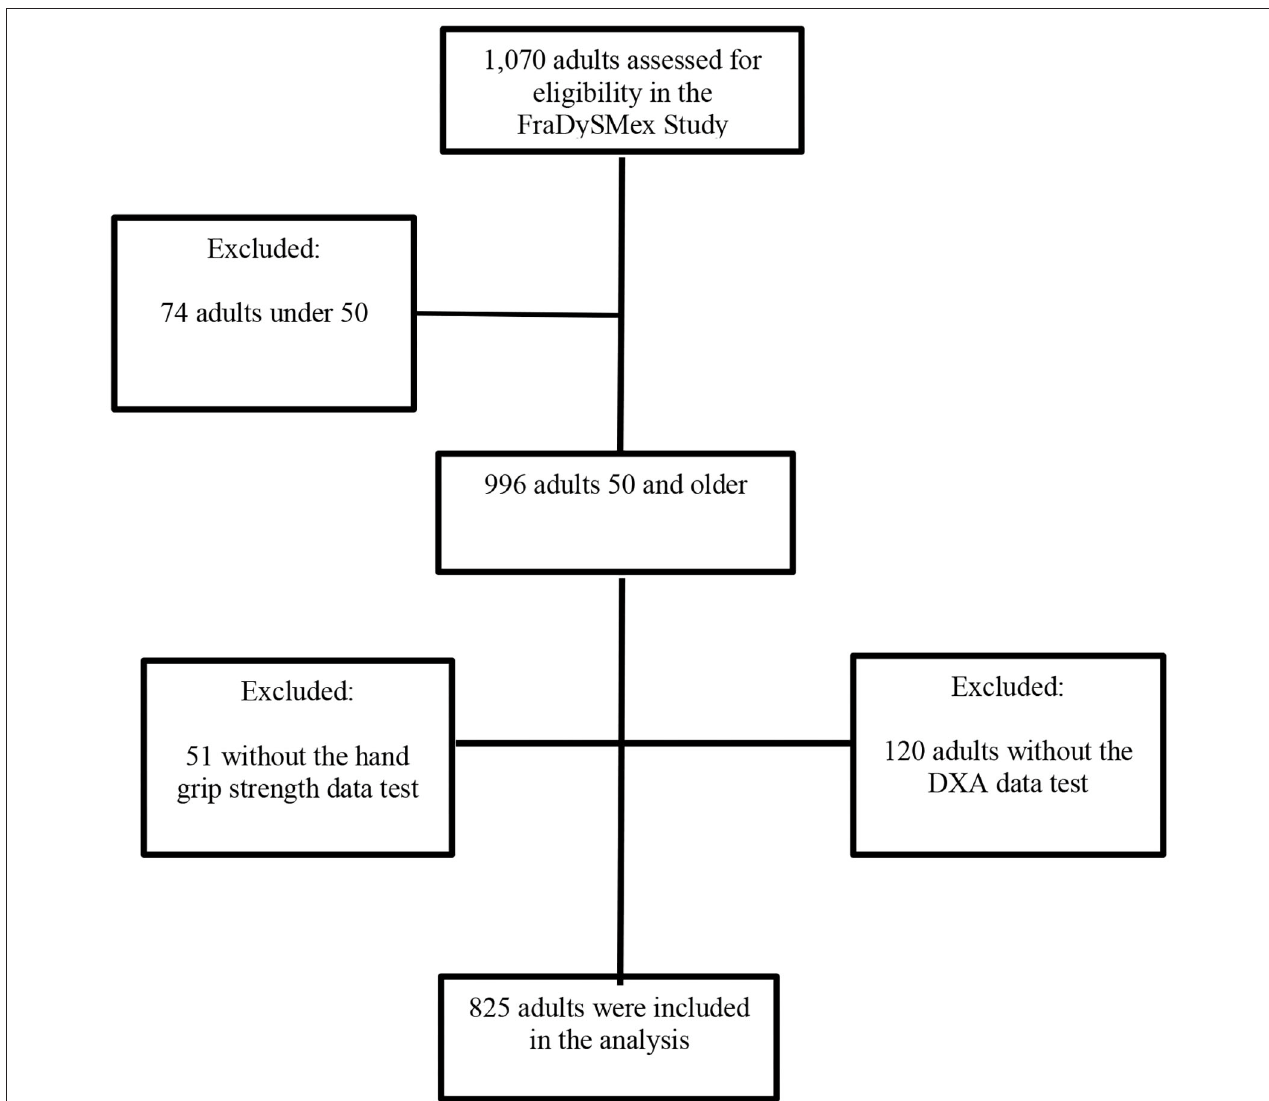
FIGURE 1 | Flowchart of FraDySMex (Frailty, Dynapenia, and Sarcopenia in Mexican adults Study (FraDySMex). DXA, dual-energy X-ray absorptiometry.